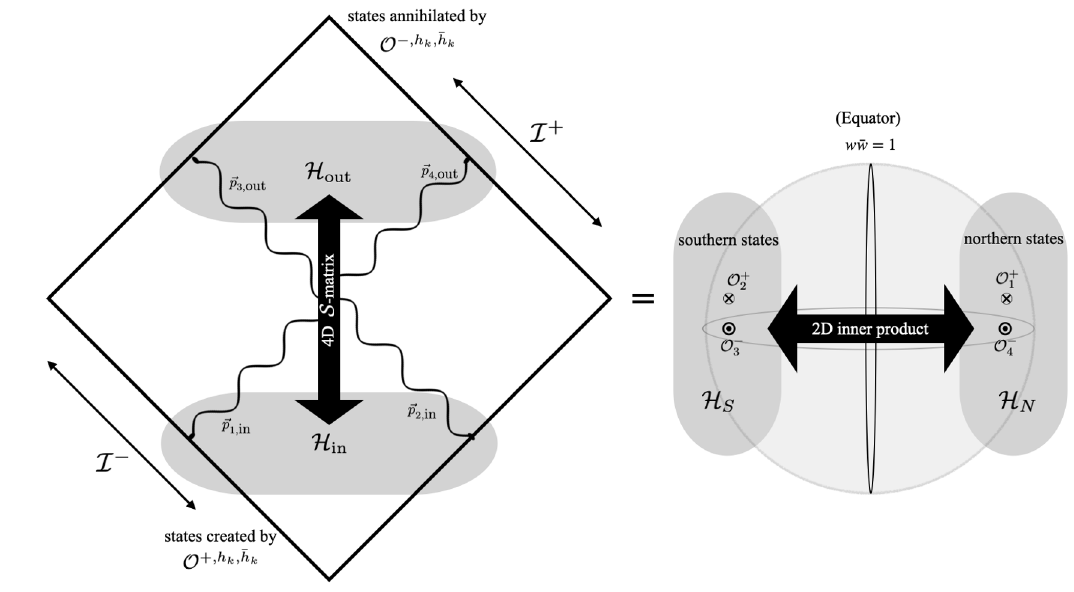
Figure 2 . On the left we depict the 4D scattering problem. Incoming states are in the Hilbert space H in at I − and outgoing states are in the Hilbert space H out at I + . The bulk scattering problem is to relate these two Hilbert spaces. On the right we depict the 2D scattering problem. In the northern (southern) hemisphere we have northern (southern) states, those originating at the south (north pole) of I − , and they form the Hilbert space H N ( H S ). The dots represent operators that annihilate the northern (southern) states on I + and the crosses represent antipodally mapped operators that create the northern (southern) states on I − . The boundary scattering problem is to find the overlap between the states in these two Hilbert